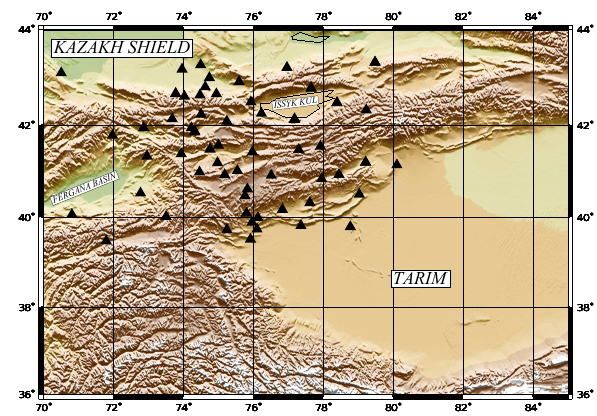
Figure 1. Topographic map of the study region and the seismograph